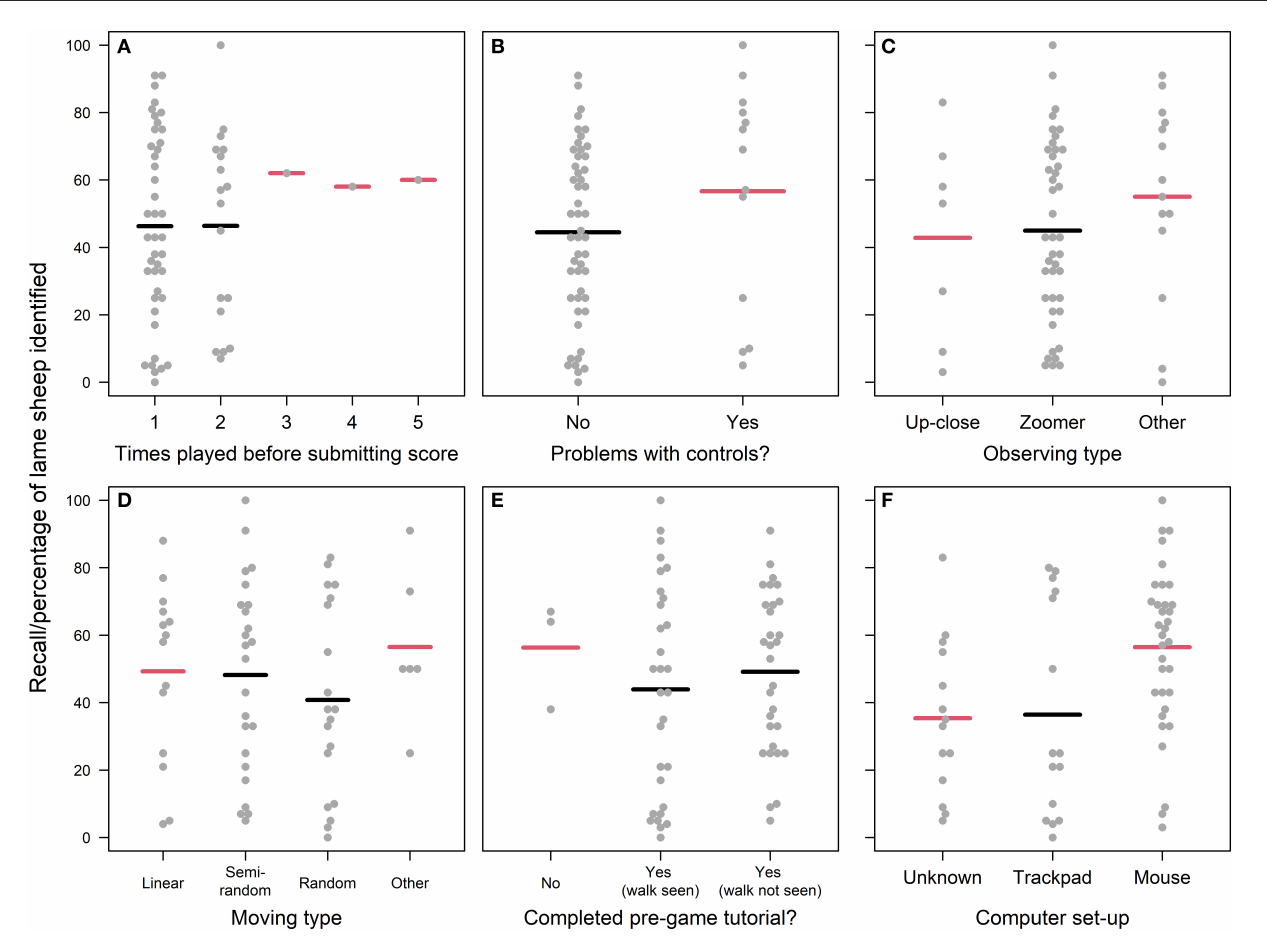
FIGURE5 Recall scores of participants according to (A) how many times the participant played the game before submitting scores; (B) Whether the participant had problems using the game controls; (C) Whether the participant observed the sheep up-close, from afar and then zooming in, or using another strategy (e.g., combination of the two); (D) How the participant navigated the virtual field to identify sheep; (E) Whether the participant completed the pre-game tutorial; (F) The participant’s computer set-up/pointing device. Individual participant data points are jittered using the beeswarm algorithm (R Package “beeswarm”) and mean recall scores are plotted as bold horizontal lines underneath the data points. Mean recall scores colored red are those likely to be poor estimates due to small sample sizes i.e., the lower or upper quartile exceeds the 95% confidence limits of the mean. The plot is framed in a bold outline if that relationship was formally tested statistically. For a more detailed explanation of what the categories mean (particularly for “observing type” and “moving type”) please refer to Supplementary material 2.